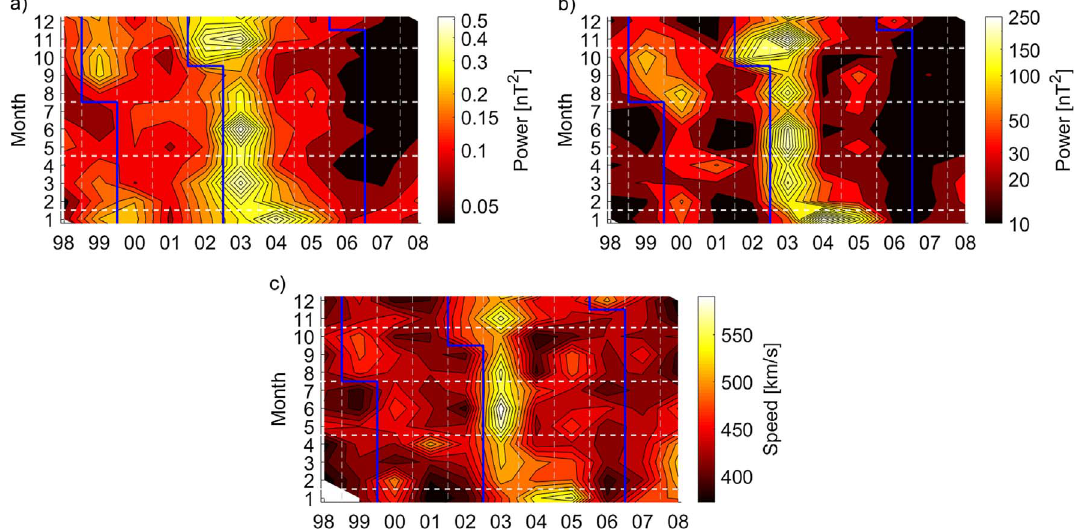
Fig. 3. Monthly mean value of (a) IMF ULF power, (b) ground ULF power, and (c) solar wind speed in 1998 – 2008. Each vertical bin contains the mean log monthly ULF power in (a) and (b), and the mean radial solar wind speed in (c). White dashed lines separate the fi gures by seasons, and blue solid lines show the places where the solar cycle phase